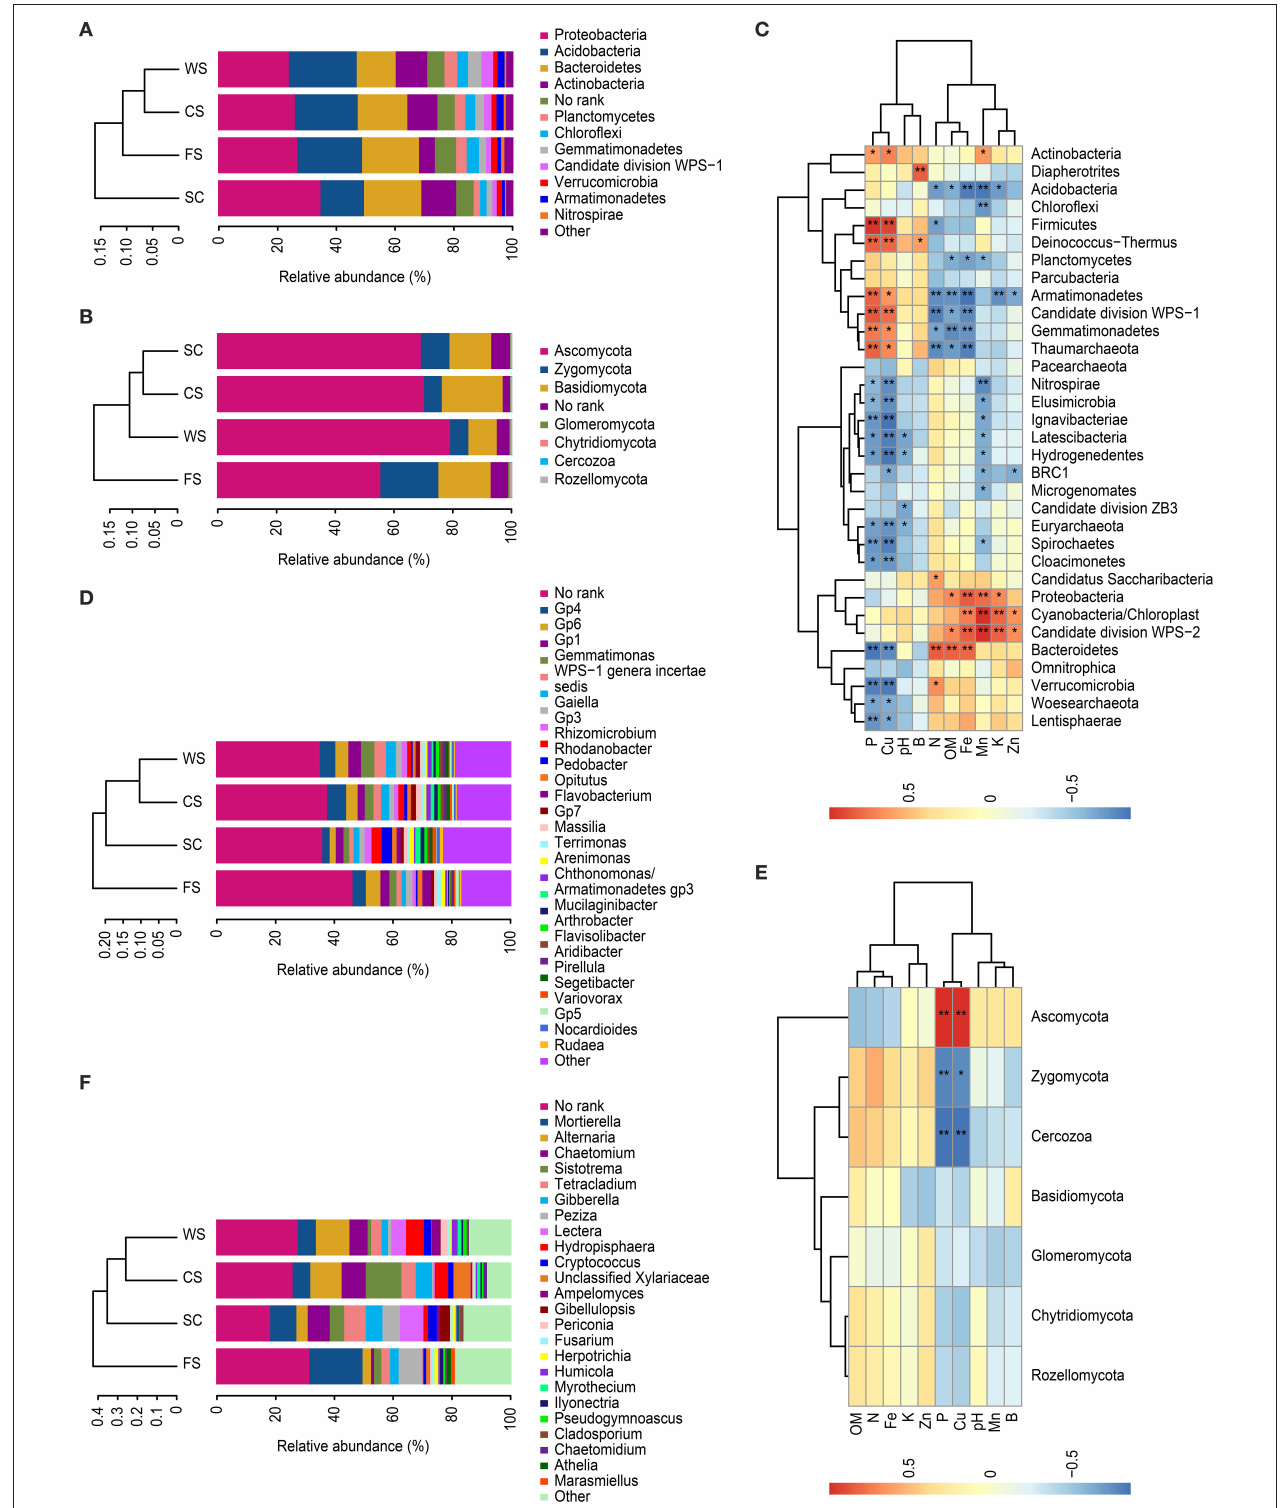
FIGURE 2 | Analysis of microbial community abundance. (A,C,D) : bacteria. (B,E,F) : fungi. (A,B) : histograms of the phyla. (D,F) : histograms of the genera. (C,E) : heat map. The histograms show the relative abundances (%) of the phyla or genera. Heat map: redundancy analysis identified ten selected soil physico-chemical variables